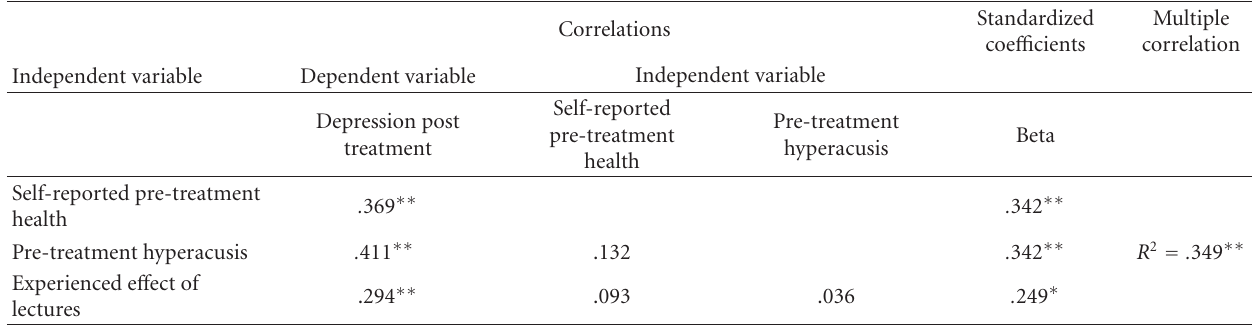
Table 6: Results of simultaneous multiple regression of the variation in depression after 5-year follow-up ( n =